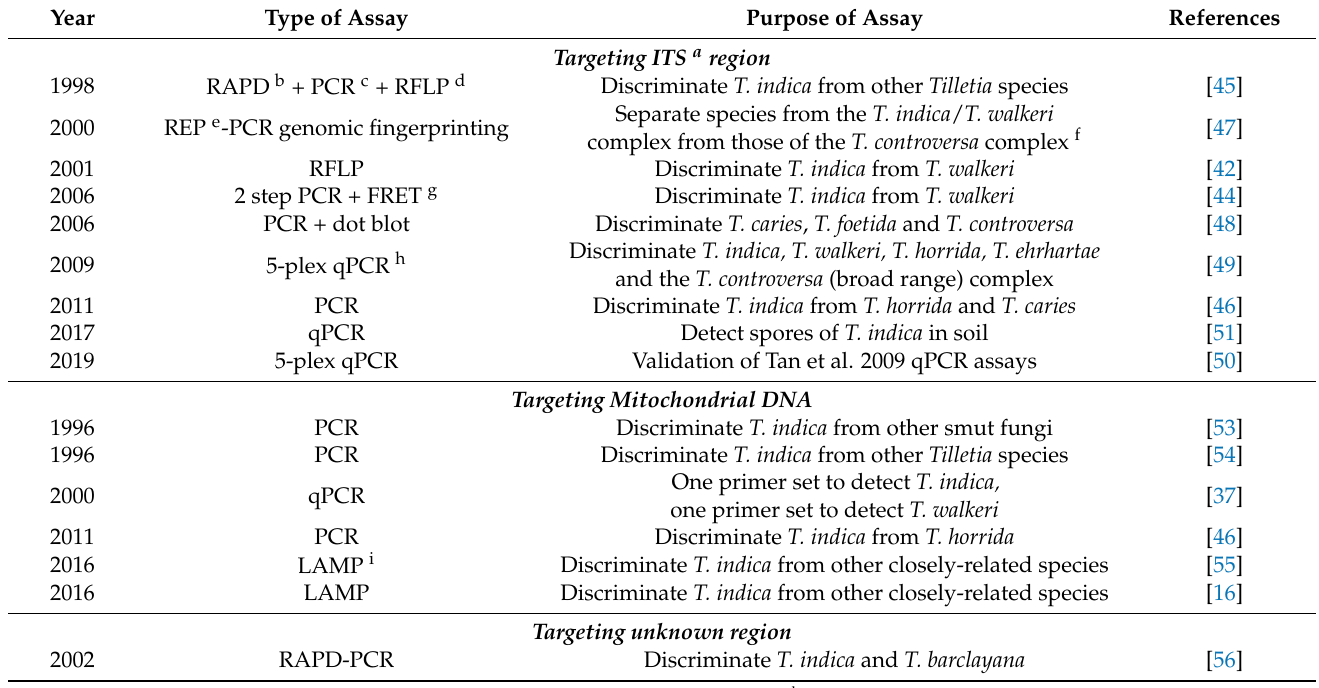
Table 1. Chronological summary of assays developed to detect or discriminate Tilletia